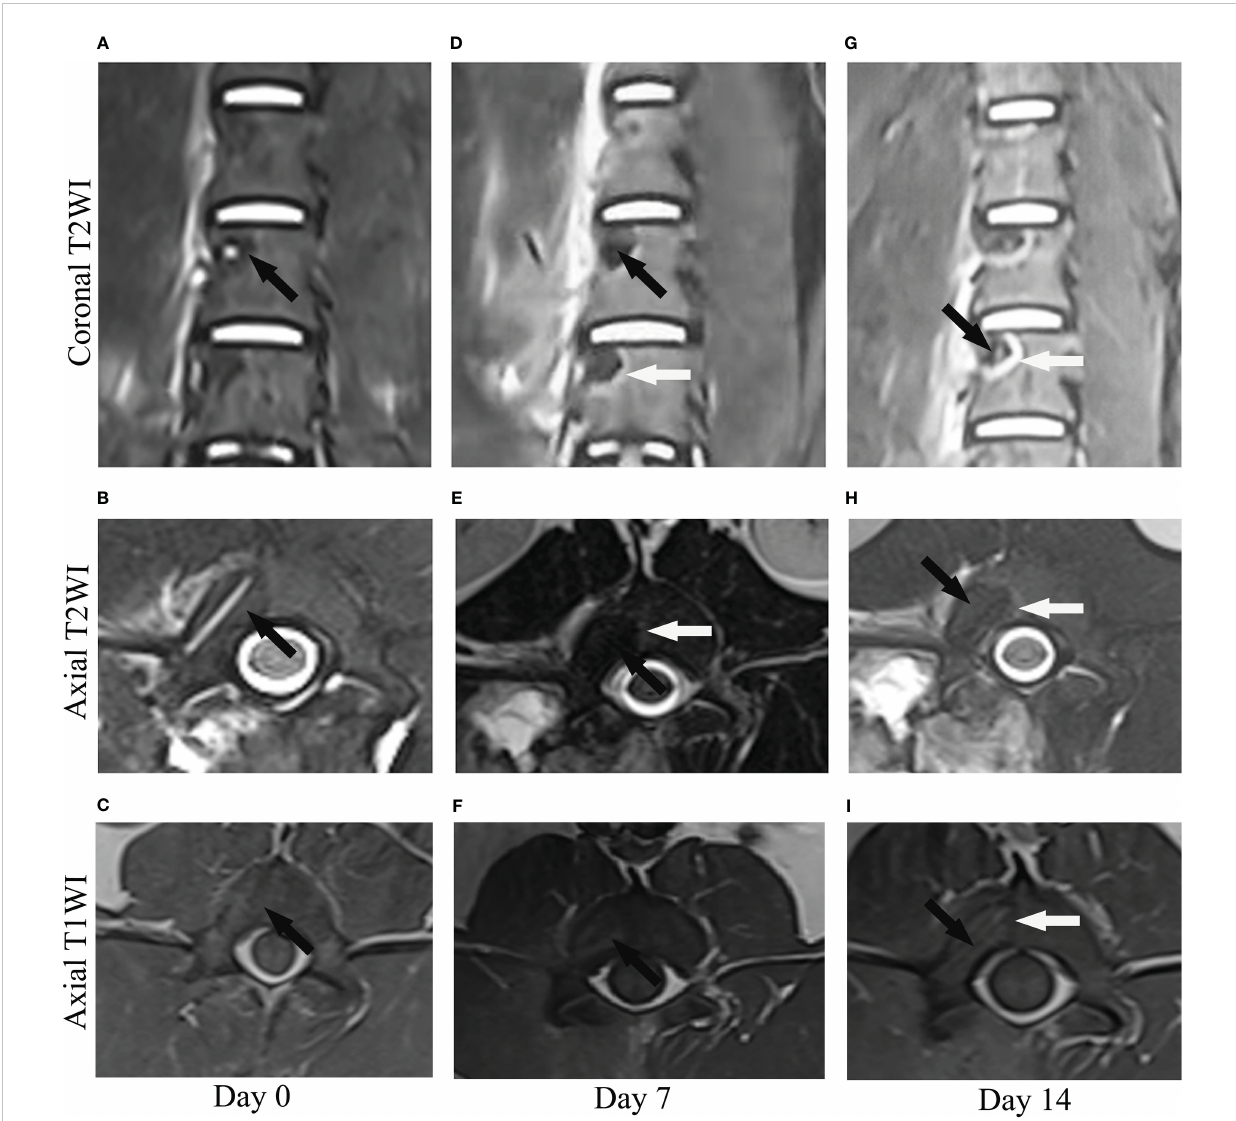
FIGURE 2 The image manifestation of a lesion on coronal and axial T2-weighted images (T2WI) and axial T1-weighted images (T1WI) at different time points (day 0, 7, 14) after radiofrequency ablation. (A – C) On day 0, the lesion showed hypointensity (black arrow) on coronal and axial T2WI and isointensity (black arrow) on axial T1WI. (D – F) On day 7, the lesion demonstrated hypointensity (Black arrow) at the center with hyperintensity (white arrow) at the periphery on coronal and axial T2WI and heterogenous intensity at the center with slightly hypointensity at the periphery on axial T1WI (Black arrow). (G – I) On day 14, the peripheral ring (white arrow) which manifested as hyperintensity on coronal and axial T2WI and hypointensity at the center was clearer than that of day